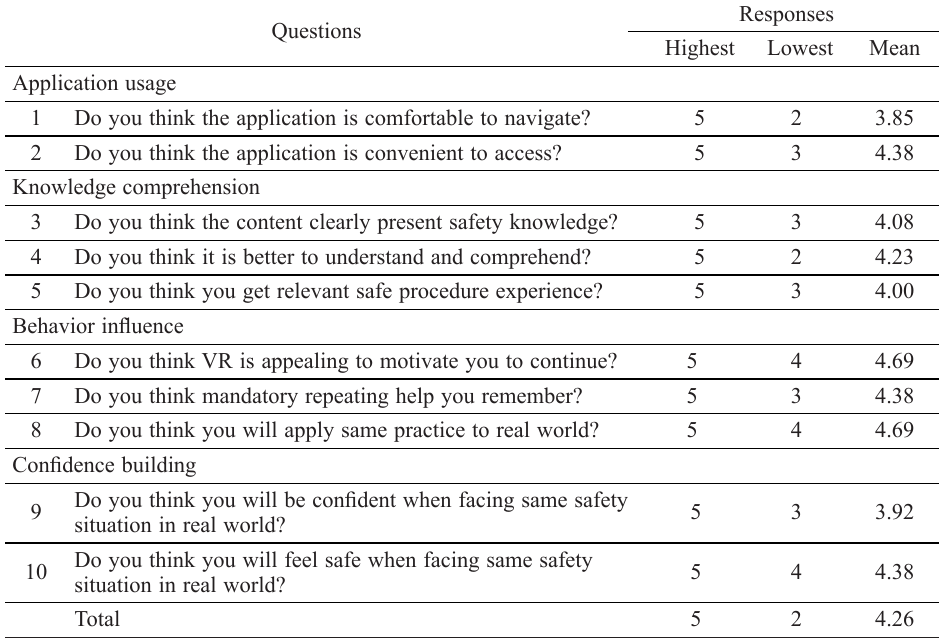
Table 1. Survey results for preliminary